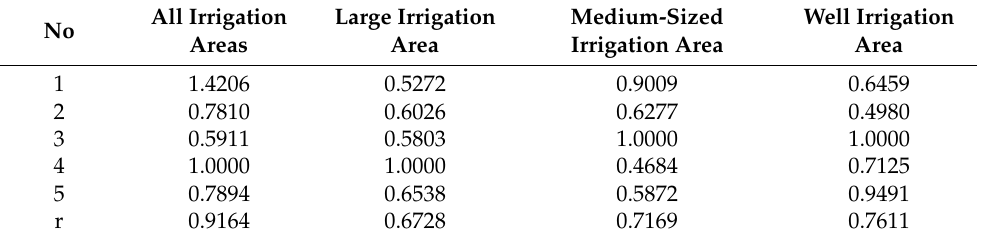
Table 5. Correlation coefficient η ( k ) and correlation degree r for various types of irrigation areas.